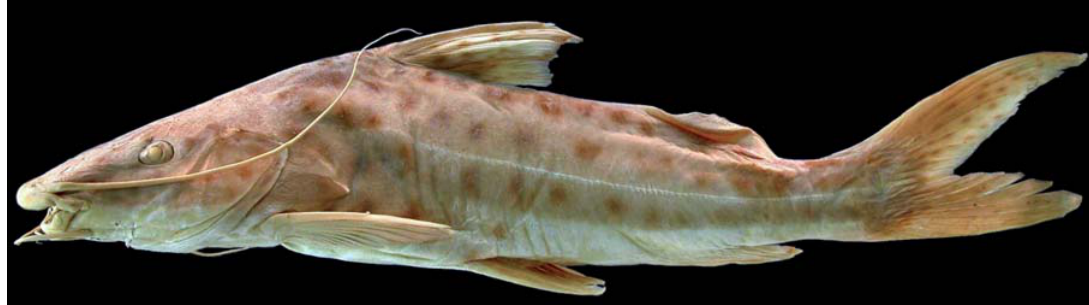
Fig. 4. Lateral view of Pimelodus britskii , FMNH 105098, holotype, 297.0 mm SL, rio Iguaçu, União da Vitória.